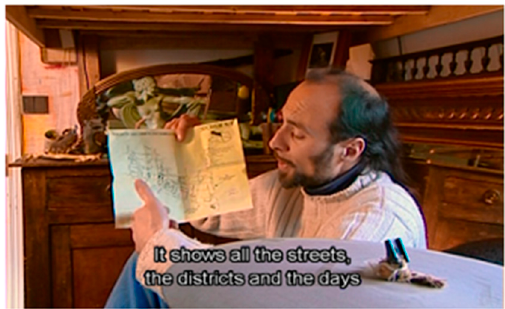
Figure 12. The artist, Hervé, shows Varda the map which, from his perspective, councils helpfully produce to allow people to see where and when they can pick up objects unwanted by others.